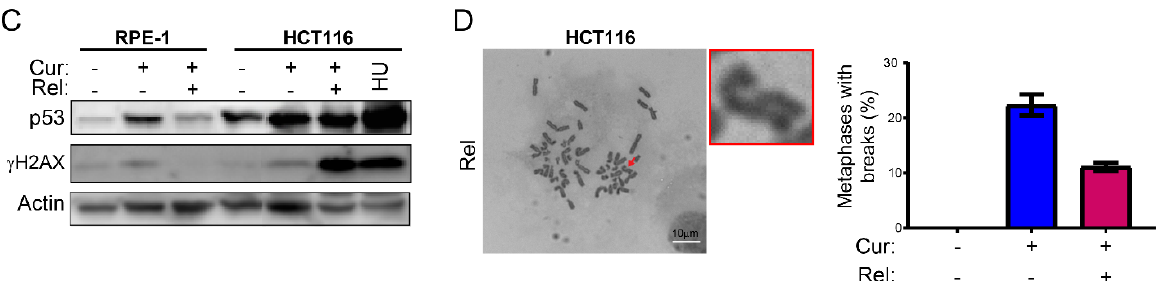
Figure 2. Curcumin treatment induces mitotic slippage and DNA damage: ( A ) Representative Giemsa-staining images of metaphase spreads of HCT116 cells with the indicated treatment. Enlargements of few chromosomes are attached on the right. Scale bar = 10 µm. Graph showing the percentage of endoreduplicated cells for each indicated sample. n = 3. Un-paired t -test: ** p < 0.01, * p < 0.05; ( B ) representative immunofluorescence images showing gH2AX-positive HCT116 and RPE-1 cells in the indicated cell treatment. Scale bar = 10 µm. Graph summarizing the results of one experiment for HCT116 cells and two independent experiments for RPE-1 cells; ( C ) immunoblots of cell extracts with antibodies against p53 and γ H2AX. HCT116 cells treated with hydroxyurea (HU) are used as a positive control for DNA damage. Antibody against actin is used as a loading control; ( D ) Representative metaphase spread image showing chromosome break in HCT116 cells with the indicated cell treatment. Arrows indicate chromosome. On the right side, there is an enlargement of a broken chromosome. Scale bar = 10 µm. Graph summarizing the results of two independent experiments.